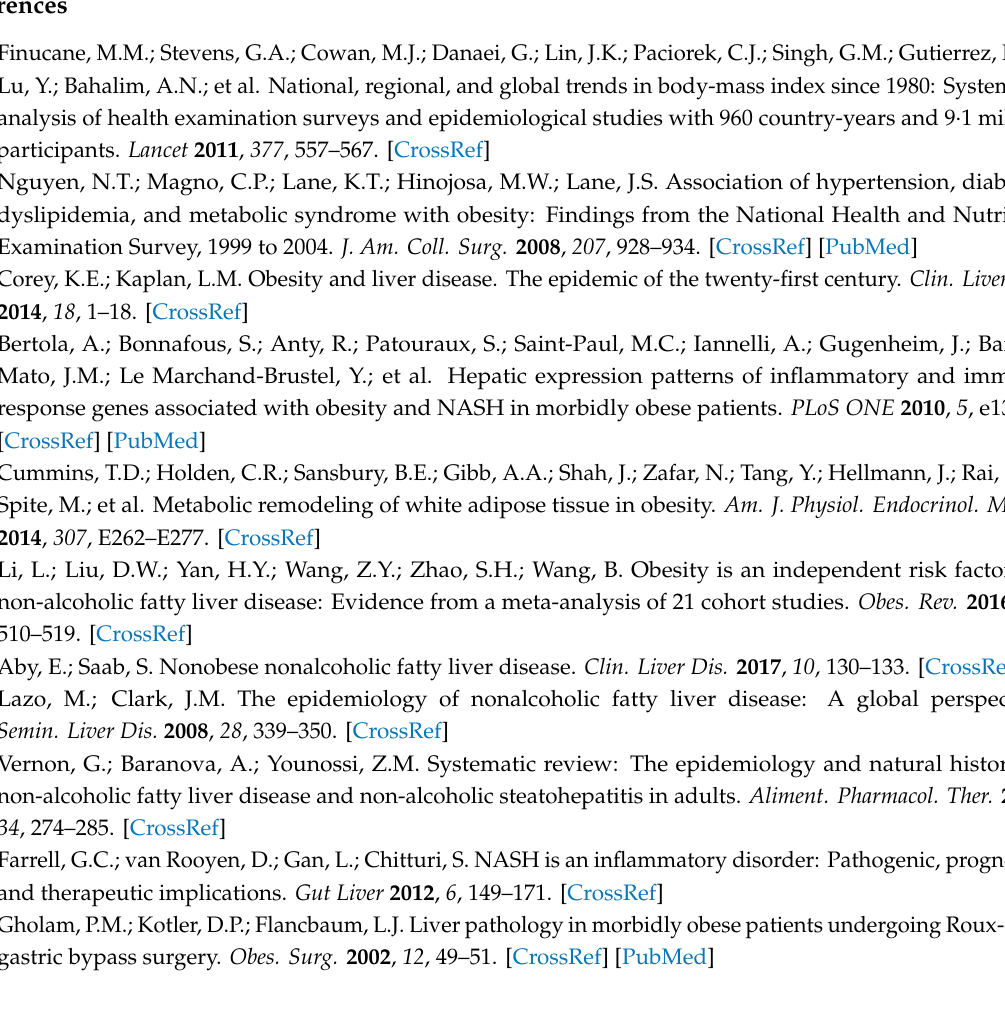
Table S2: Primer sequences used for RT-PCR amplification of